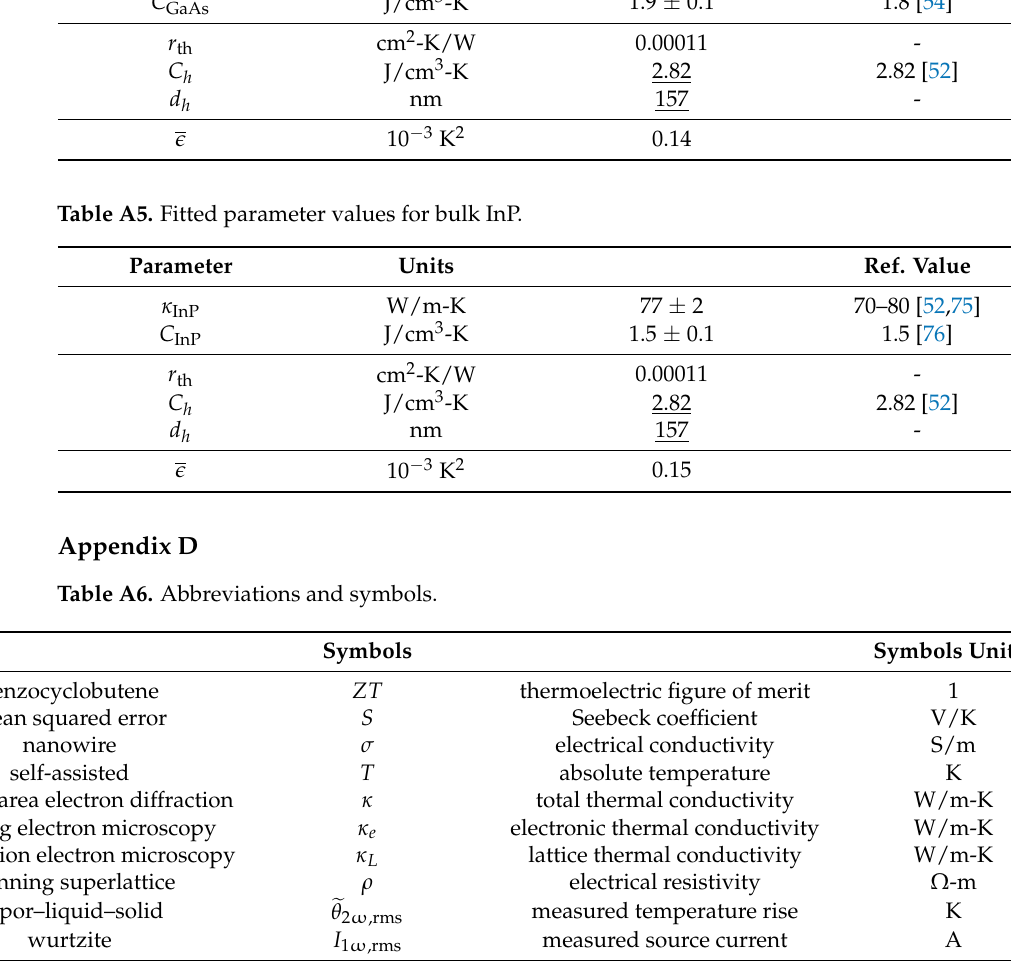
Figure A1. Measured and fitted temperature amplitudes for bulk GaAs and InP samples. Shaded regions around the data points indicate the measurement uncertainty.